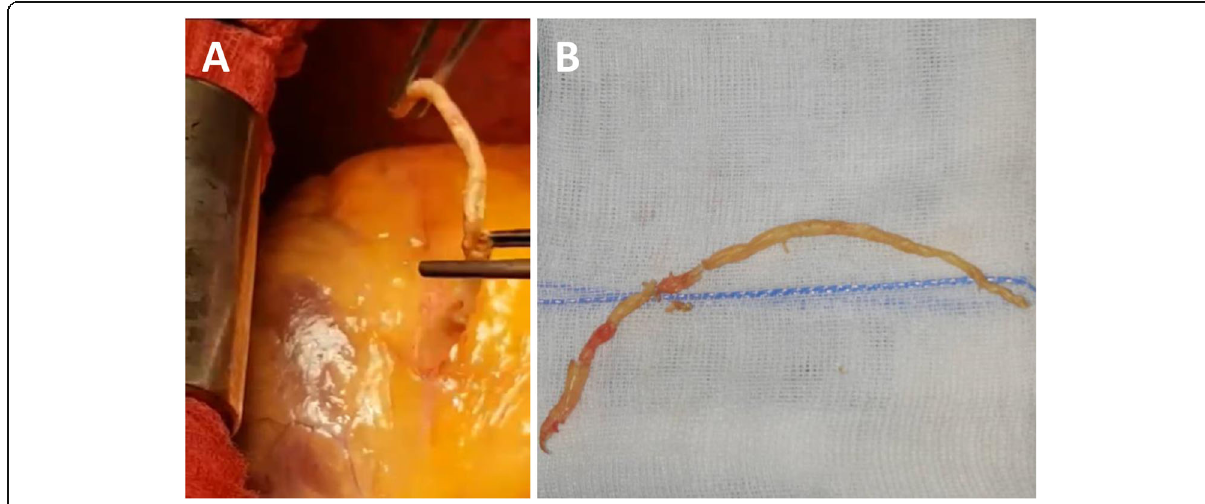
Fig. 1 a Endarterectomy of the left anterior descending artery. b Atheroma extracted from the left anterior descending